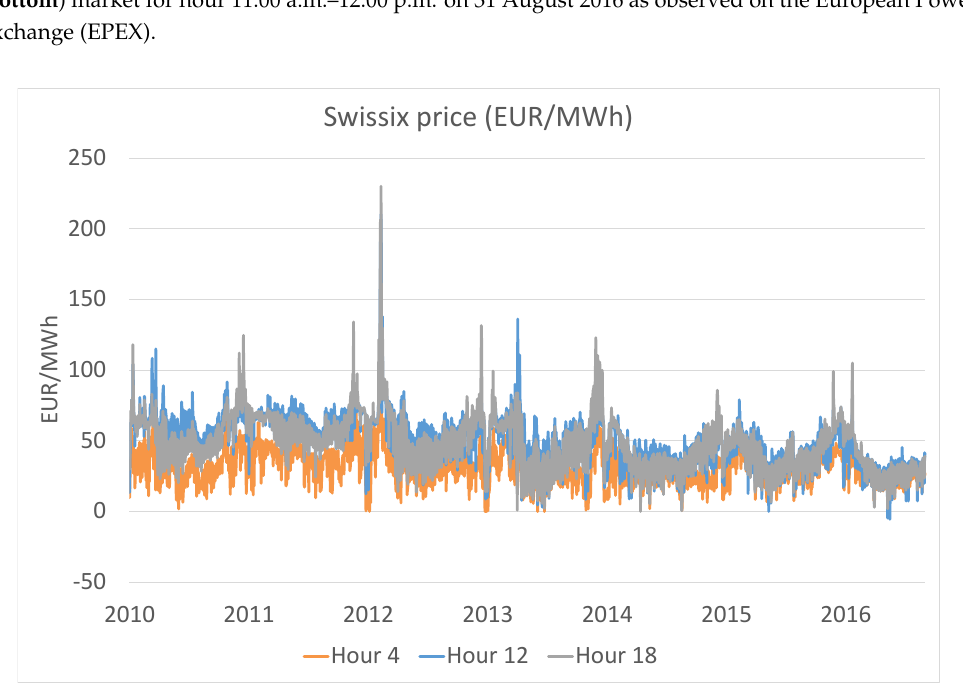
Figure 4. Swissix electricity price evolution 1 January 2010 until 31 August